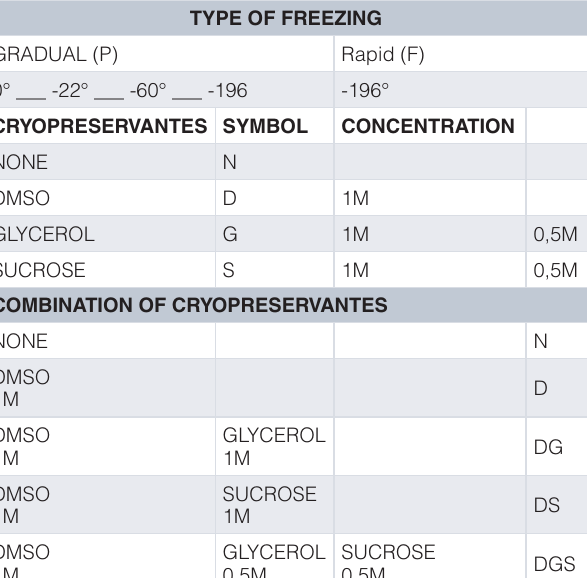
Table 1. System design and freezing seed symbology used for cryoprotective substances and their concentrations. M: molar.